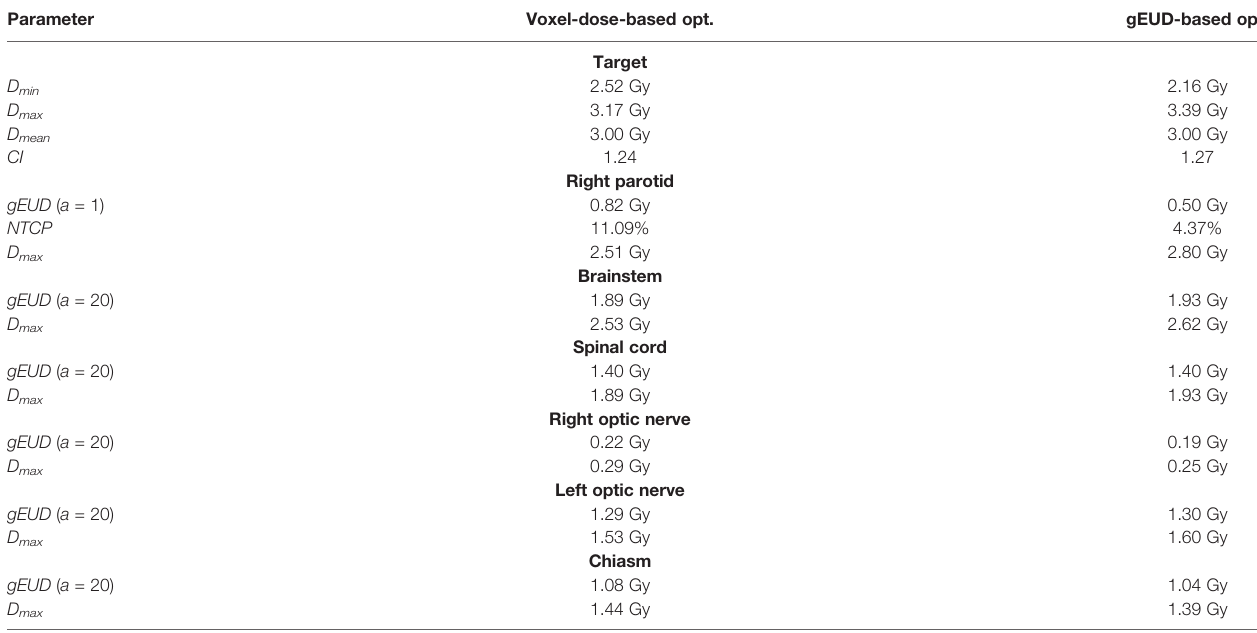
CI = volume 95% isodose / volume VOI. gEUD, generalized equivalent uniform dose; OAR, organ at risk; NTCP, normal tissue complication probability; VOI, volume of interest.